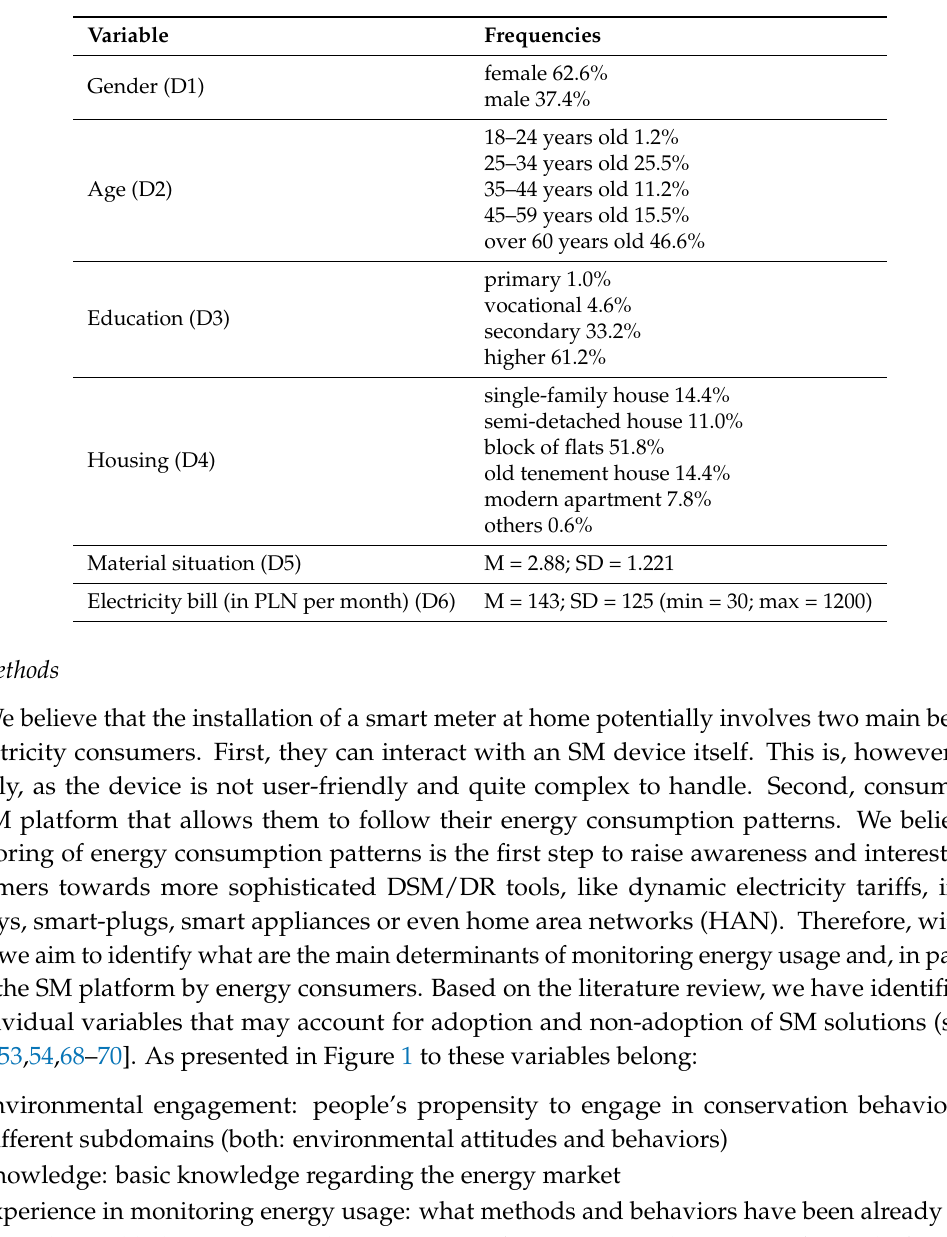
Table 2. Frequencies of the demographic variable